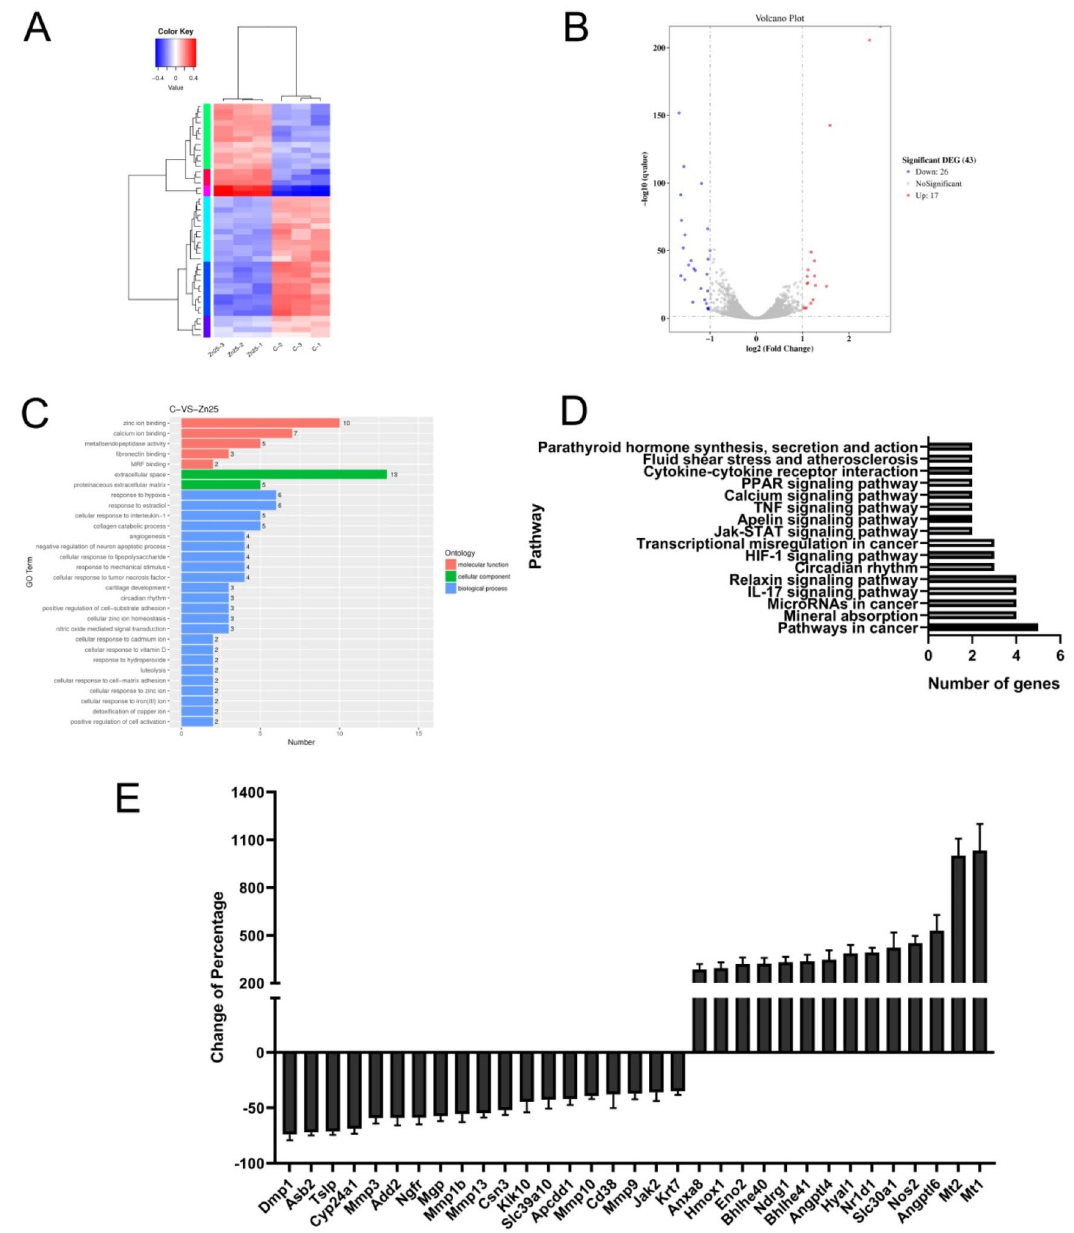
Figure 3. Gene expression changes in 4T1 cells after Zn{[CH 3 ) 3 C] 2 Sal} 22− treatment analyzed by RNA-seq. ( A ) Hierarchical clustering of differentially expressed mRNAs between control and Zn{[CH 3 ) 3 C] 2 Sal} 22− (25 μM)-treated 4T1 cells. ( B ) A volcano plot shows differentially expressed RNAs after treating 4T1 cells with Zn{[CH 3 ) 3 C] 2 Sal} 22− . ( C ) The enriched cell functional classifications for the DEGs in 4T1 cells after treatment with Zn{[CH 3 ) 3 C] 2 Sal} 22− . ( D ) The top 16 enriched pathways for the DEGs in 4T1 cells after treatment with Zn{[CH 3 ) 3 C] 2 Sal} 22− . ( E ) mRNA expression levels in Zn{[CH 3 ) 3 C] 2 Sal} 22– treated 4T1 cells verified by